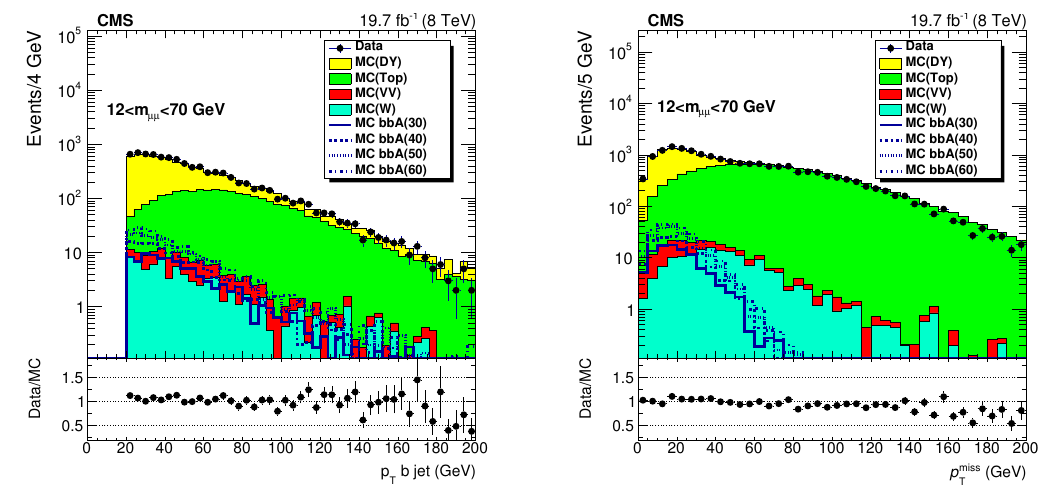
Figure 2 . The transverse momentum of the leading p T b jet (left) and the missing transverse momentum (right) for data (dots) and simulation (histograms). The histograms for simulated backgrounds are stacked. The histogram labeled as MC(Top) shows the sum of the single top and top quark pair production processes. The expected signal is shown assuming a signal cross section times branching fraction of 350 fb. The background is normalized to the number of events expected from simulation. In the lower panel, the ratio of the number of events in data and background simulation is shown.